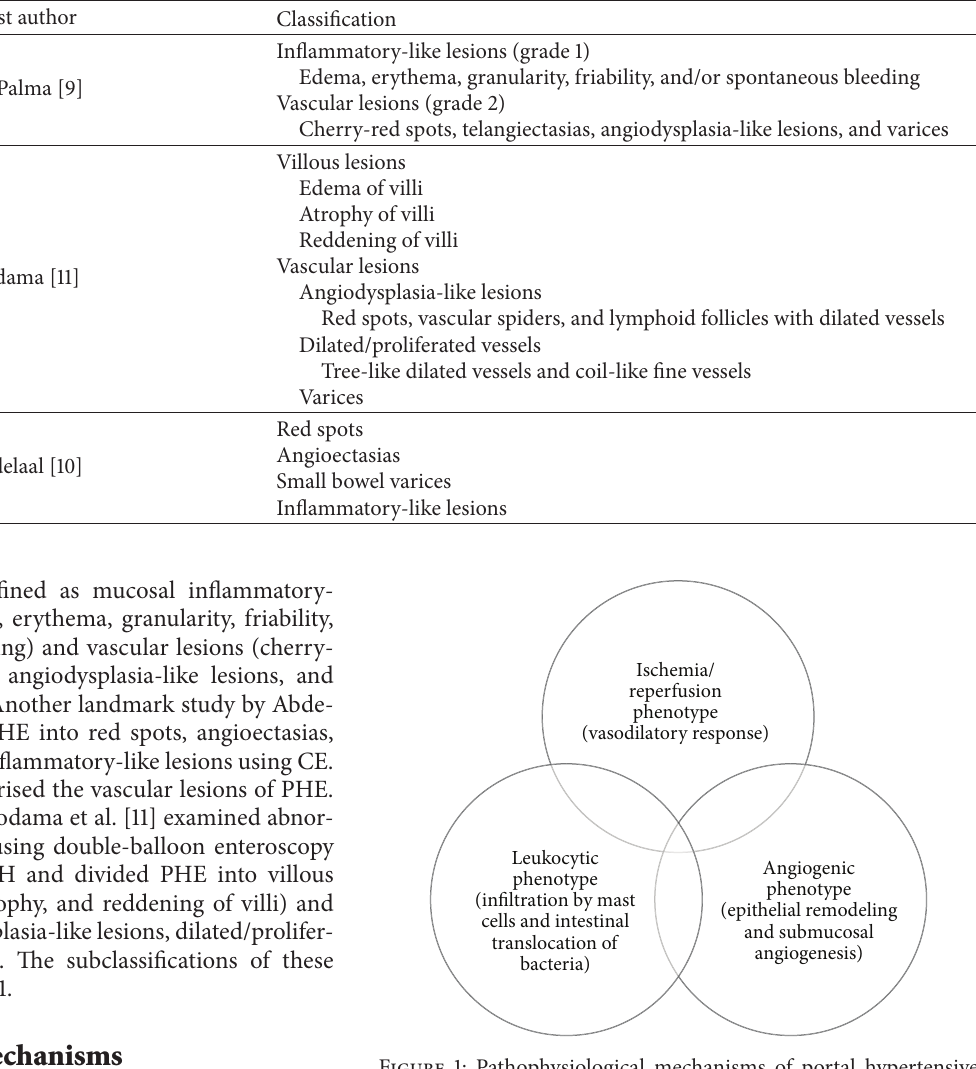
Figure 1: Pathophysiological mechanisms of portal hypertensive enteropathy in a rat model. Modified from Aller et al.